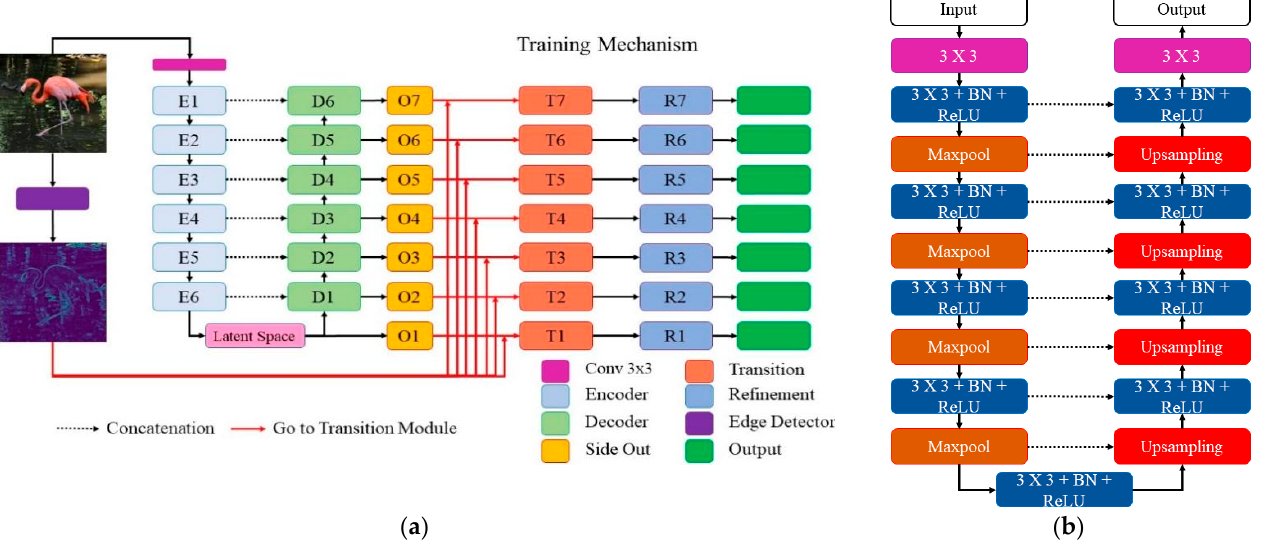
Figure 1. Overall architecture of the proposed MEAN method. ( a ) Training flow of MEAN ( b ) Refinement module architecture.